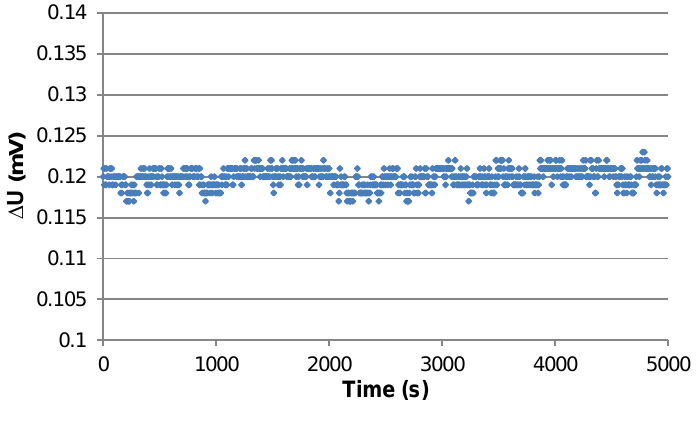
Figure 7. Representation of the detection limit of the flow